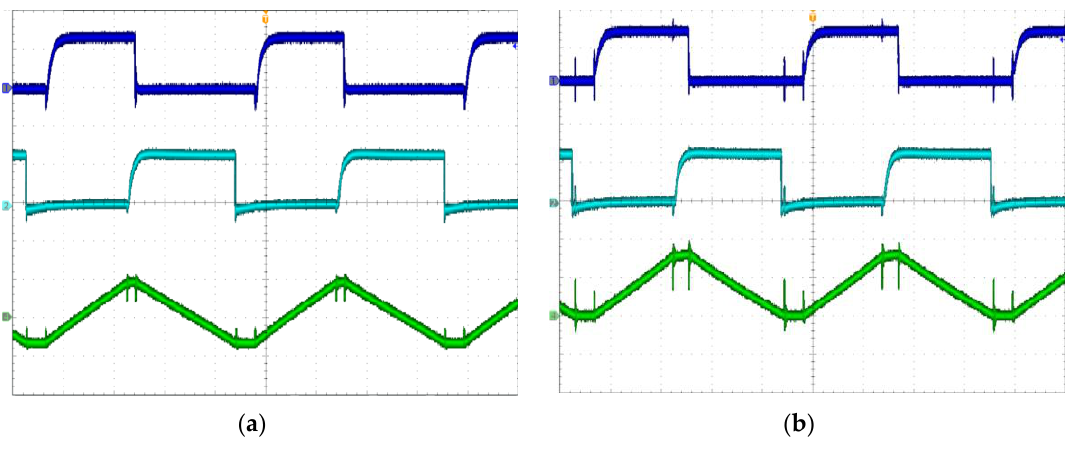
Figure 16. Measured waveforms under fixed phase-shift value (148°). ( a ) 50 W; ( b ) 300 W. (CH1: 10 V/div, CH2: 10 V/div, CH4: 1 A/div, Time: 8 μs/div)